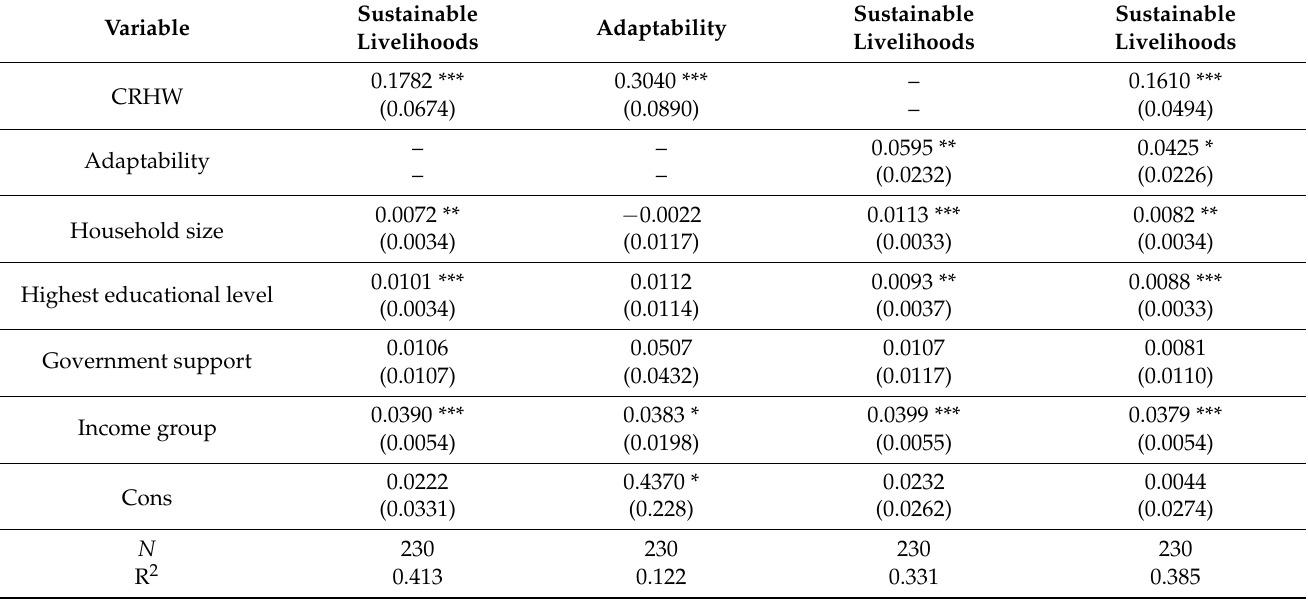
Table 4. Mediation analysis of adaptability between the CRHW and sustainable